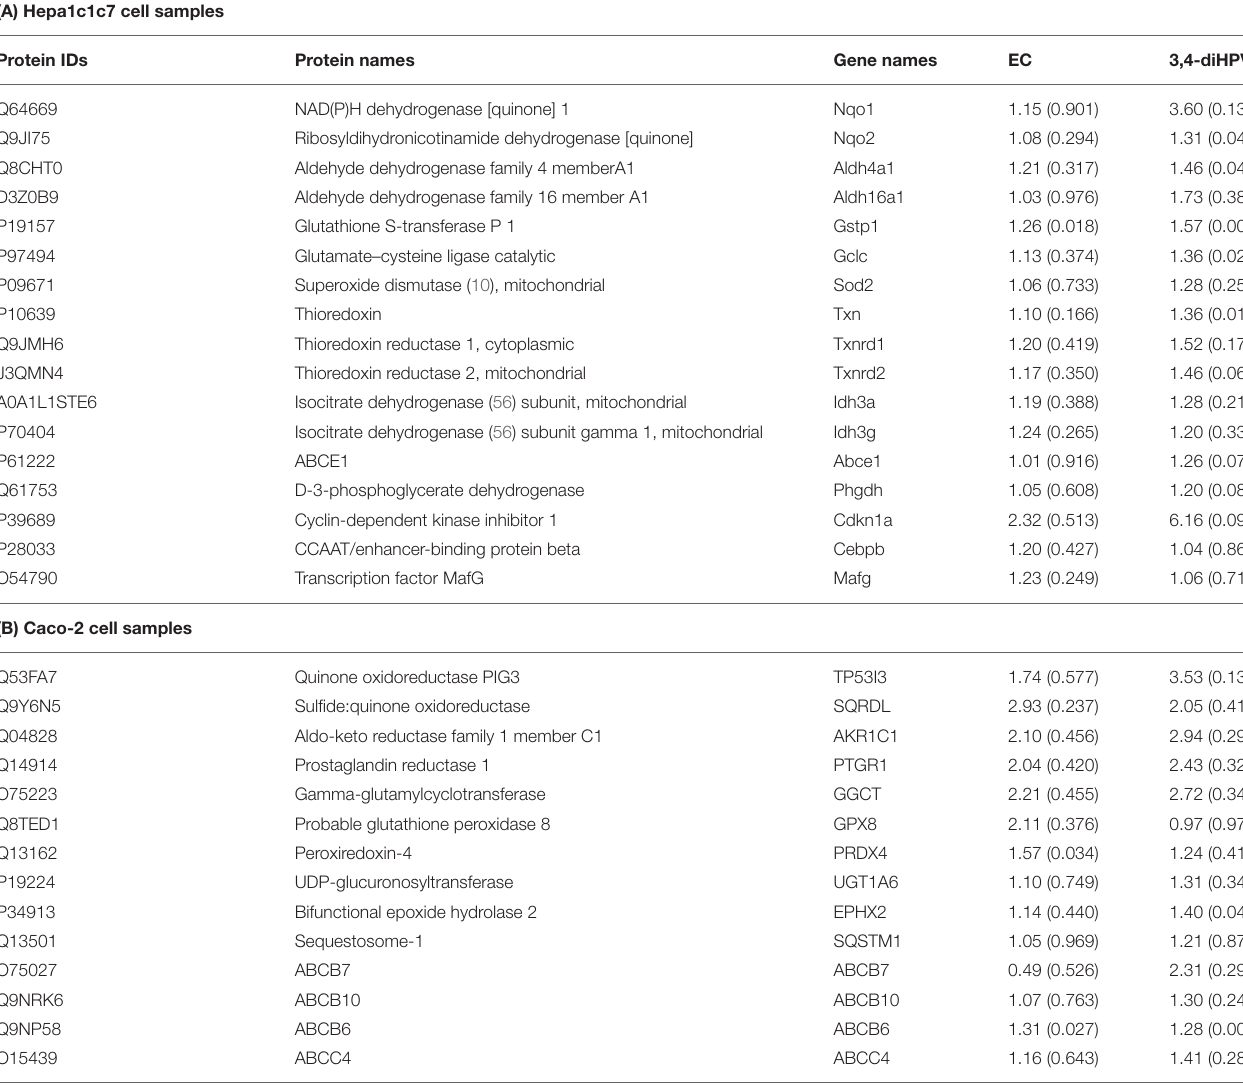
TABLE 1 | A comparison of fold change (FC) of Nrf2-associated proteins after exposure to EC and 3,4-diHPV for 24 h at 30 µ M. (A) Hepa1c1c7 cell samples Protein